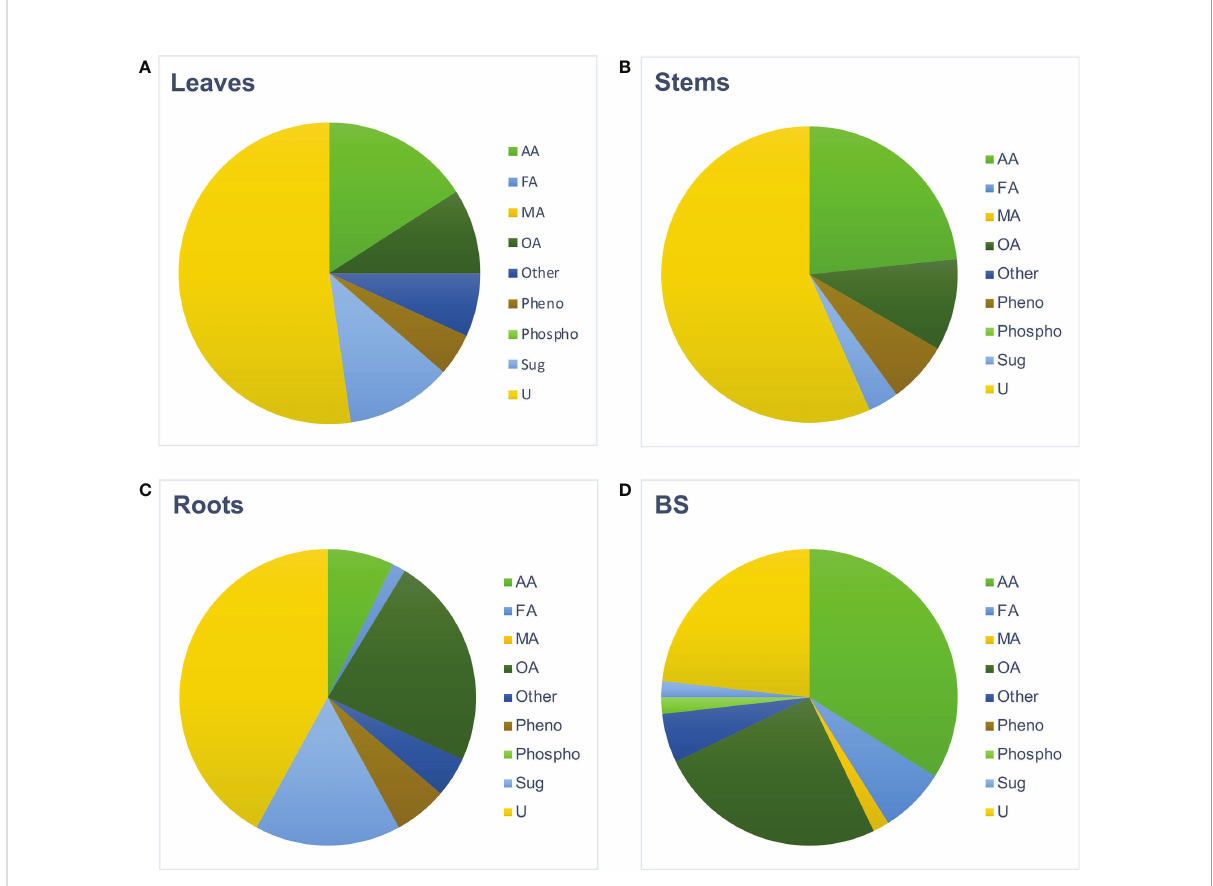
FIGURE 4 Distribution by biochemical families of the metabolites detected in BS and in the organs of BS-treated grapevine plantlets. Micro-cuttings were transplanted in a solid culture medium supplemented with BS 0.1% (v/v, “ BS+ ” ) or water ( “ BS- ” , as control). At 4 wpt, plantlets were collected and dissected to distinct leaf, stem and root samples. Data obtained by GC-MS analysis were processed and the metabolites signi fi cantly accumulated in leaves (A) , stems (B) , and roots (C) of BS+ plantlets, compared to BS- ones were categorized as unknown (not annotated) or according to their biochemical family (AA: Amino Acids, FA, Fatty Acids; MA, Mineral Acids; OA, Organic acids; phenol, phenolics ie secondary metabolites); Phospho, Phosphorylated compounds; Sug, Sugars; U, unknown). The same categorization was made for compounds detected in the assessed biostimulant (D)